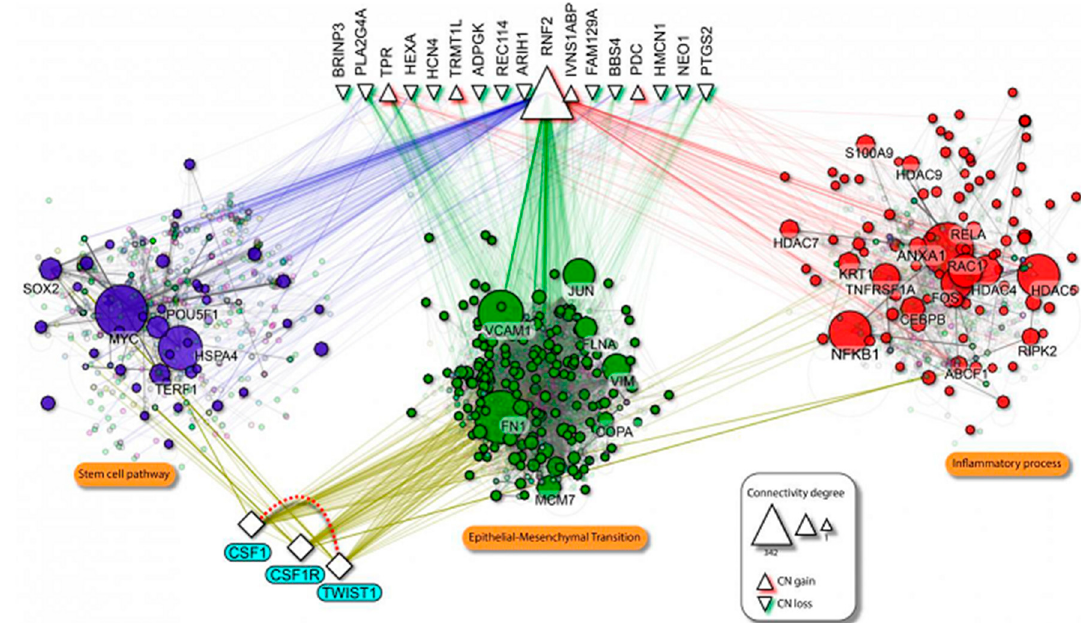
Figure 7. Scheme of the protein-protein interaction (PPI) involving TWIST1 and CSF1 network. Solid purple edges represent the interactions between enriched genes in each assessed biological process and the neighborhood interactions. Proteins enrichment was involved in critical hallmarks of cancer progression such as cancer stem cell signaling (purple circle), epithelial-mesenchymal transition (EMT) (green circle), and inflammatory process (blue circle) were detected ( p < 0.01).